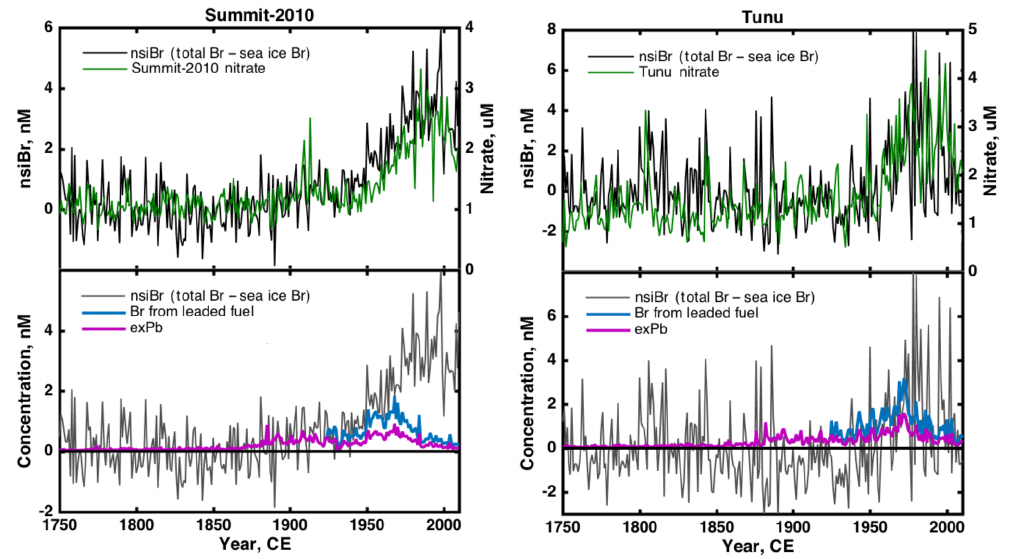
Figure 8. Upper panels: comparison between bromine in excess of what is expected from a purely sea ice source (nsiBr, black) and nitrate. The temporal similarities between the nitrate and nsiBr records are high and indicate that nitrate is a likely driving force for the enhanced release of bromine species from sea ice sources. Lower panels: comparison between the calculated nsiBr record and excess lead (exPb, purple) measured in the ice cores. The lower panels also show the upper limit to the amount of bromine that could be derived from leaded fuel combustion by assuming exPb:Br ratio of 1:2 after 1925 (blue). After 1970, when world consumption of leaded gasoline began to fall, nsiBr concentrations continued to rise at both ice core sites far above the concentrations that could be explained by leaded gasoline